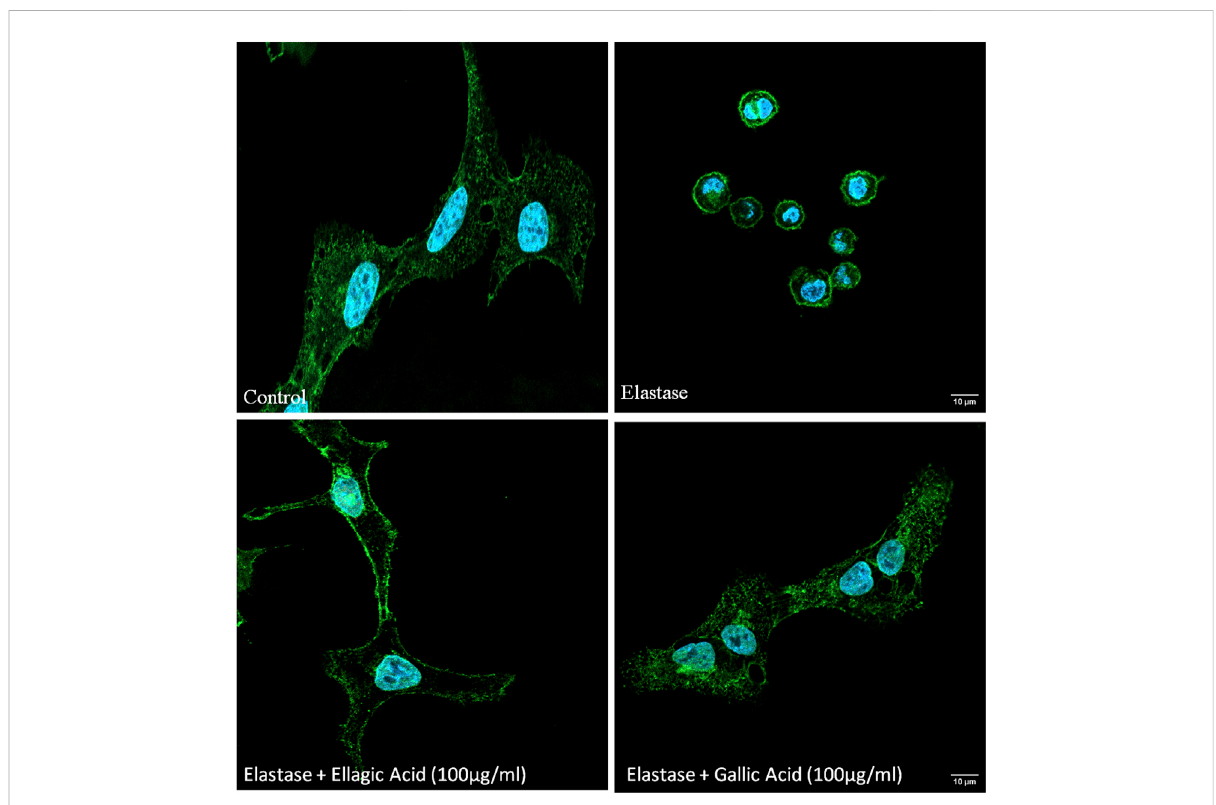
FIGURE 6 Ellagicacidandgallicacidhaveanti-elastaseeffectsandprotectagainstelastaseinducedlungmorphologicalchange.Inhibitoryeffectsofgallic acid and ellagic acid on human neutrophil elastase induced lung epithelial cells. Cell membrane was stained with WGA (green) and nucleuii were counterstained with DAPI (blue) and assessed under Confocal microscope